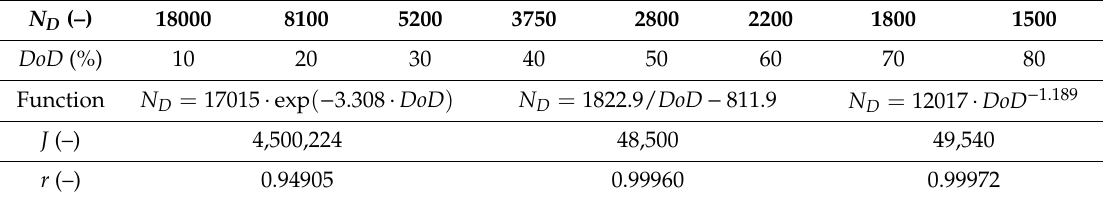
Table 8. Experimental values between the maximum number of cycles N D and the depth of discharge DoD for AGM VRLA battery system (see Table 6.7 in [11]), the functions between cycles N D — DoD adapted by LSE method and the respective values of the mean square error J and the correlation index r